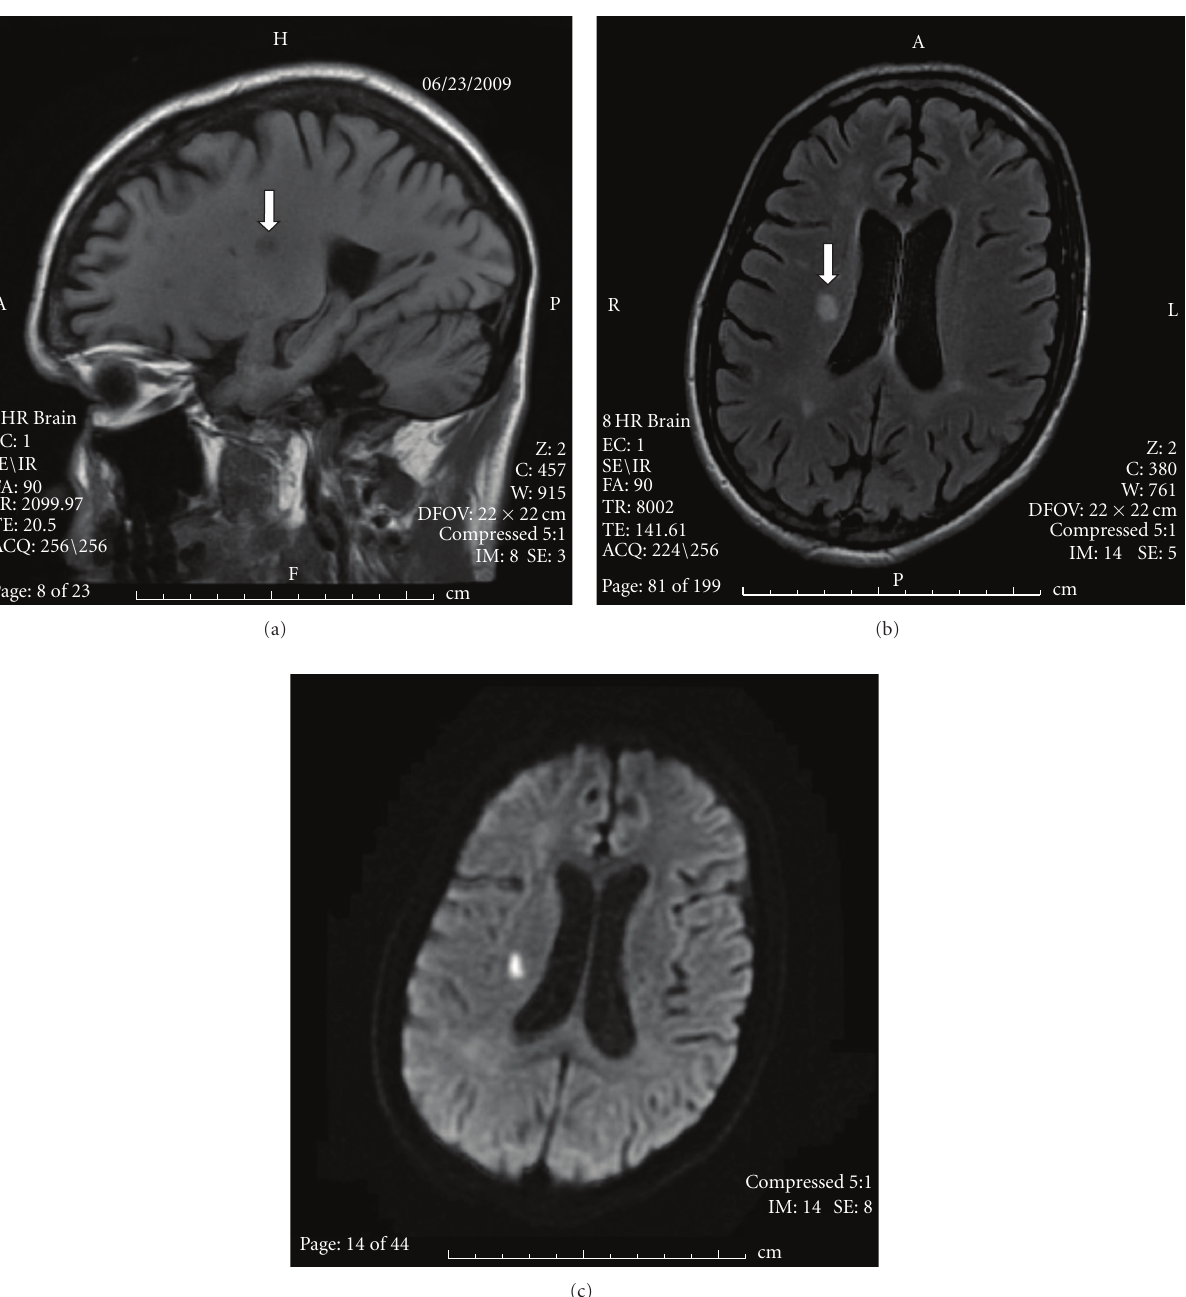
Figure 1: MRI of brain on presentation: (a) sagital view showing acute right side frontal lobe infarct marked by arrow. (b) Axial view with same right side frontal lobe infarct marked by arrow. (c) Di ff usion-Weighted Image of ischemic stroke in the right centrum